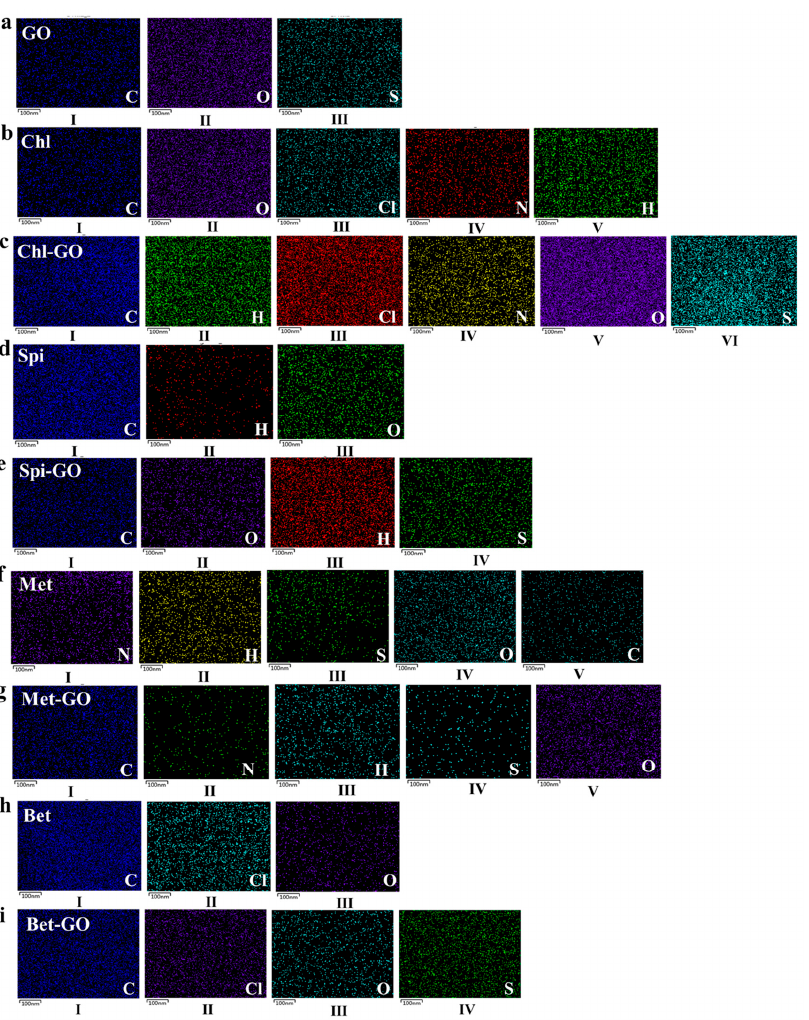
Figure 2. SEM-EDS of GO after GO ( a ), Chl ( b ), Spi ( d ), Met ( g ), Bet( h ), Chl-GO ( c ), Spi-GO ( e ), Met- GO ( g ) and Bet-GO ( i )